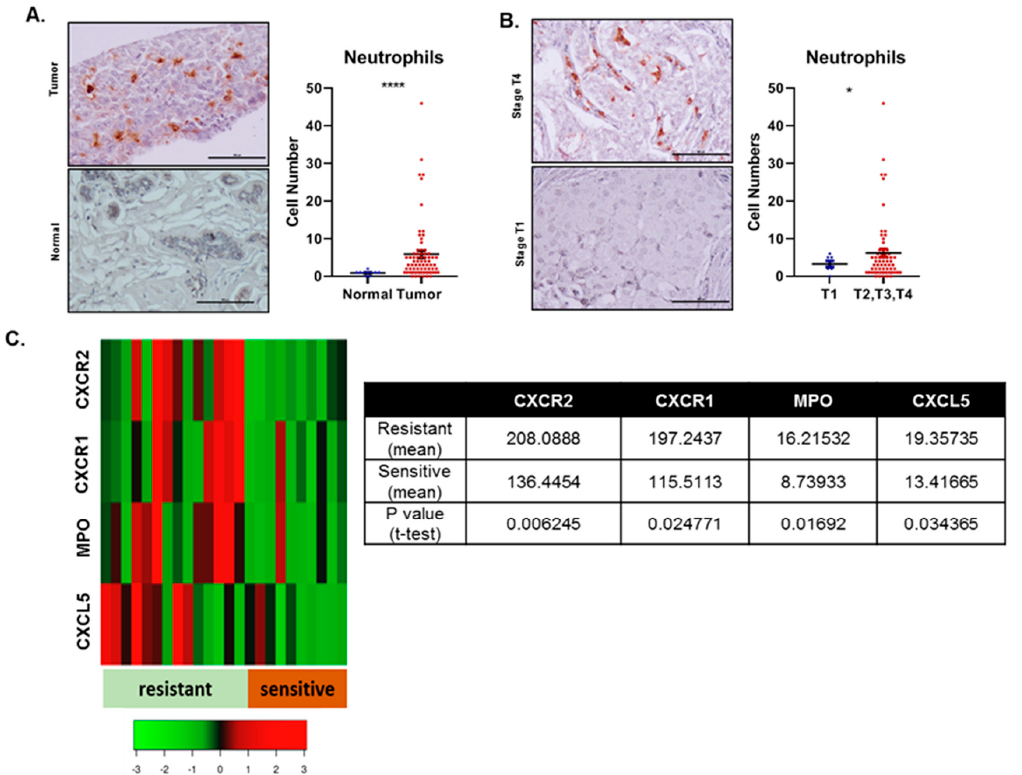
Figure 1. Neutrophils in human patients with different breast cancer stages and chemotherapy resistance. ( A ) Representative images and graphs showing higher neutrophil infiltration in the tumor tissues than normal tissues. ( B ) Representative images and graphs showing higher neutrophil infiltration in the tumors of T2, T3, and T4 stage patients (combined) compared to the tumors of T1 stage patients. The values are shown as number of neutrophils ± SEM, Unpaired t-test; * p < 0.05; **** for p ≤ 0.0001. ( C ) Heat map and table showing significantly higher levels of CXC-receptor-1 ( CXCR1 ) CXC-receptor-2 ( CXCR2 ), CXC-ligand-5 CXCL5 , and Myeloperoxidase ( MPO ) in patients resistant to docetaxel chemotherapy. The values are shown as the mean and Student’s t-test.